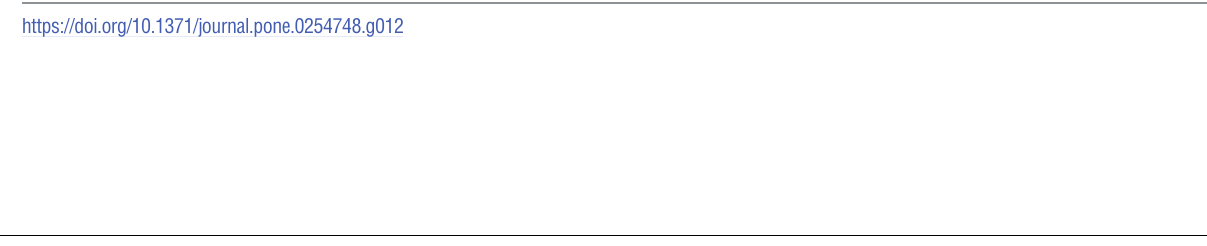
PLOS ONE | https://doi.org/10.1371/journal.pone.0254748 July 27,